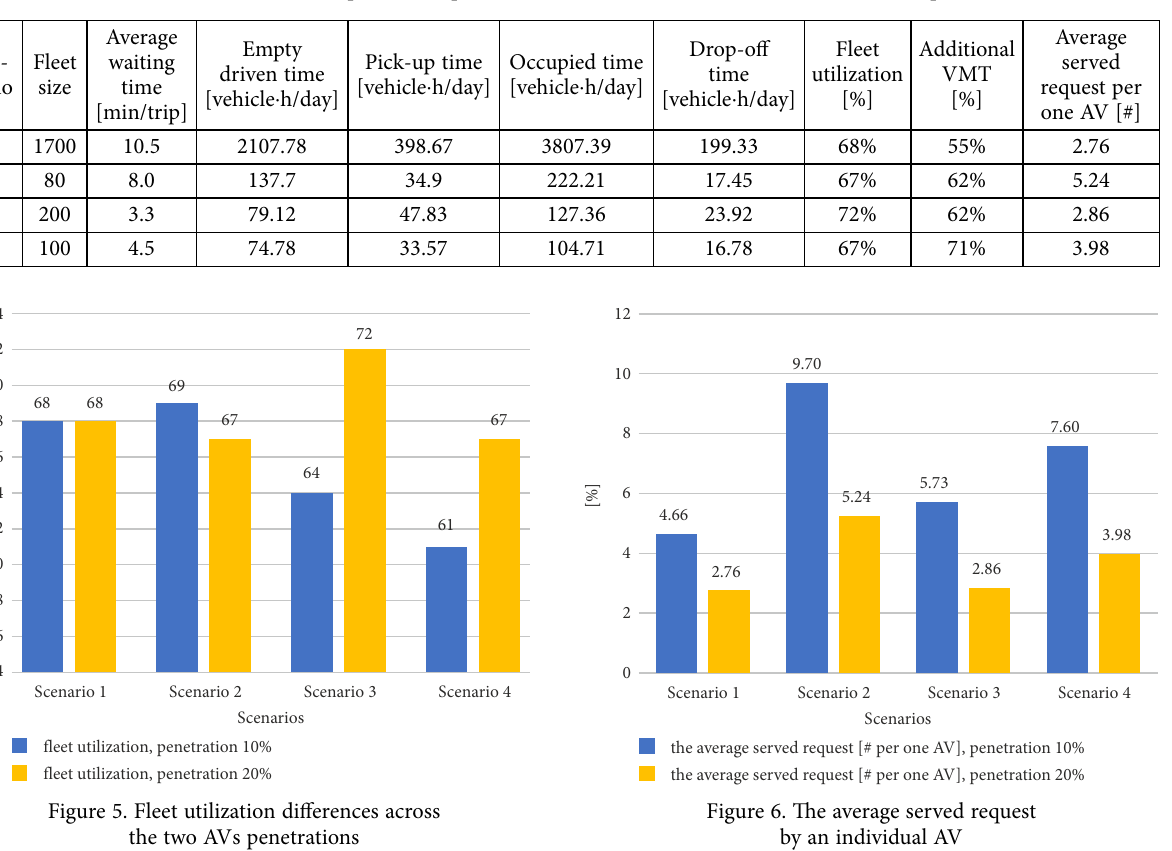
Table 4. The travellers’ trip time components when the fleet size of AVs is 20% of the sample